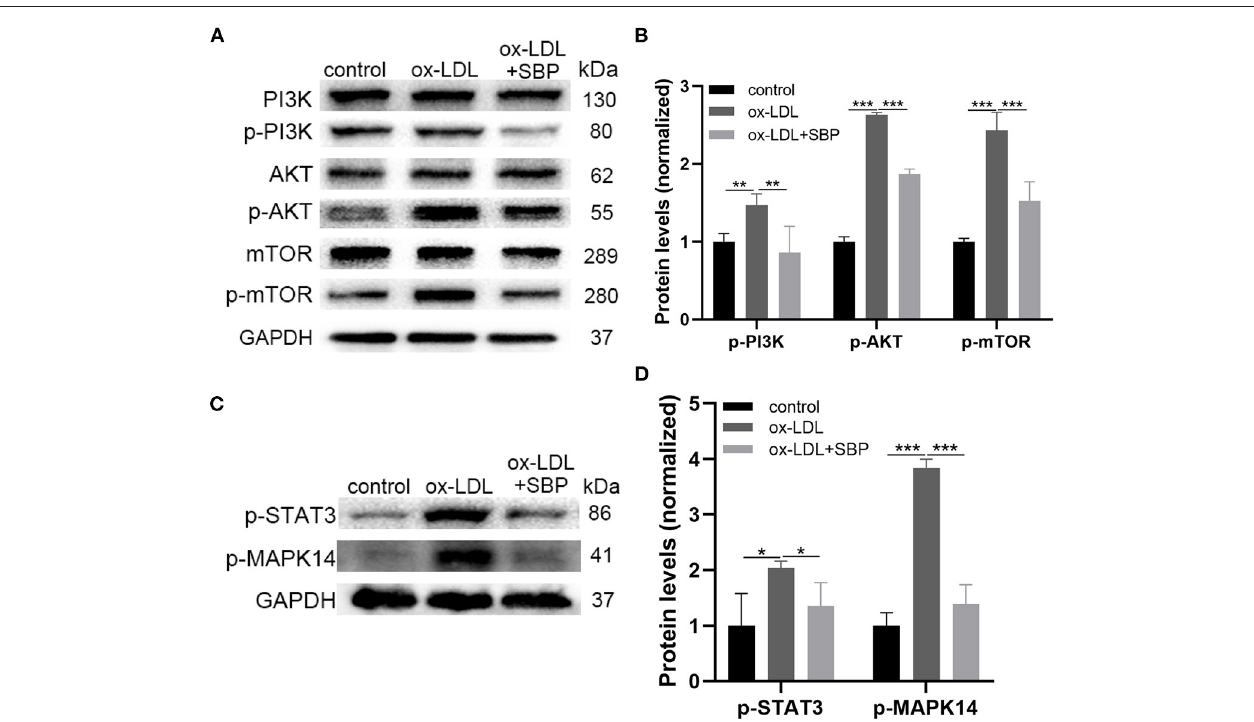
FIGURE 5 | The prediction targets and pathways of network pharmacology were validated by Western blot. (A) The expression of PI3K, p-PI3K, AKT, and p-AKT, mTOR, p-mTOR was detected by Western blot. (B) The significant difference of p-PI3K, p-AKT, and p-mTOR was revealed among the three groups. (C) Expression of top 2 targets including STAT3 and MAPK14 was investigated by Western blot. (D) Statistical analysis of Western blot. * p < 0.05, ** p < 0.01, *** p <